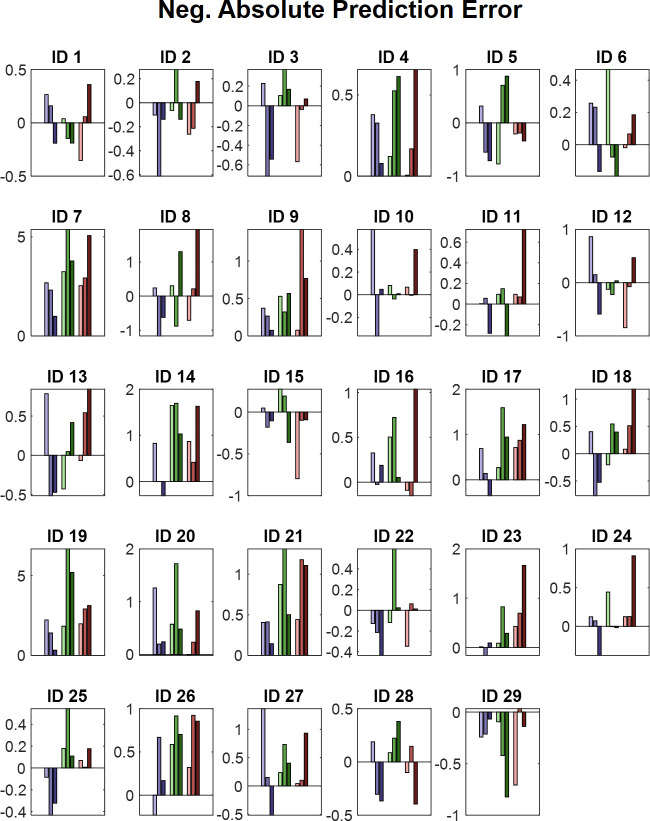
Power values for all conditions with a valid modality cue (expect heat receive heat) averaged over all significant time–frequency–electrode samples period for each subject (ID) of the negative absolute prediction error cluster.Blue colors represent low heat conditions, green colors represent medium heat conditions, and red colors represent high heat conditions. Color intensities depict expectation level.